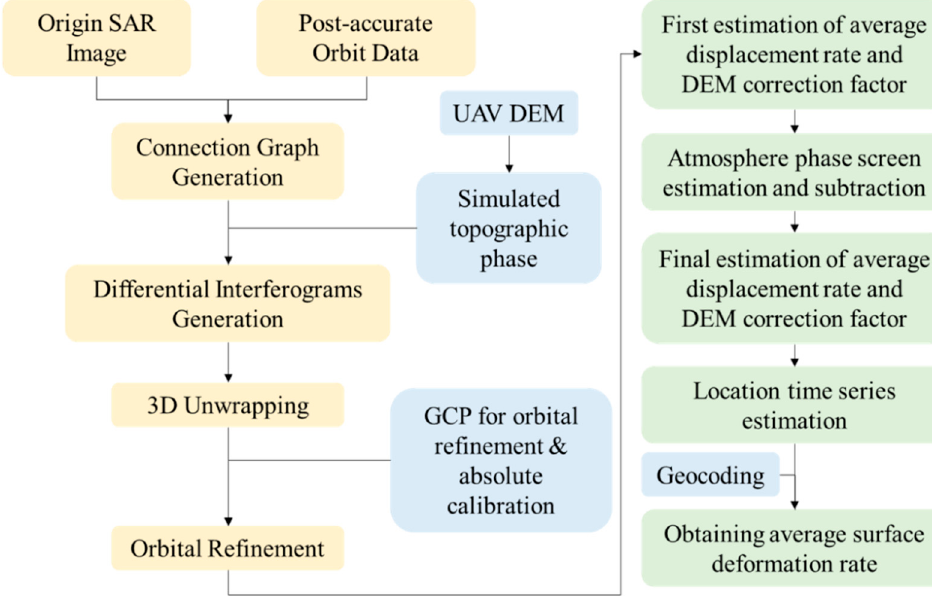
Figure 4. Workflow for InSAR surface deformation extraction.